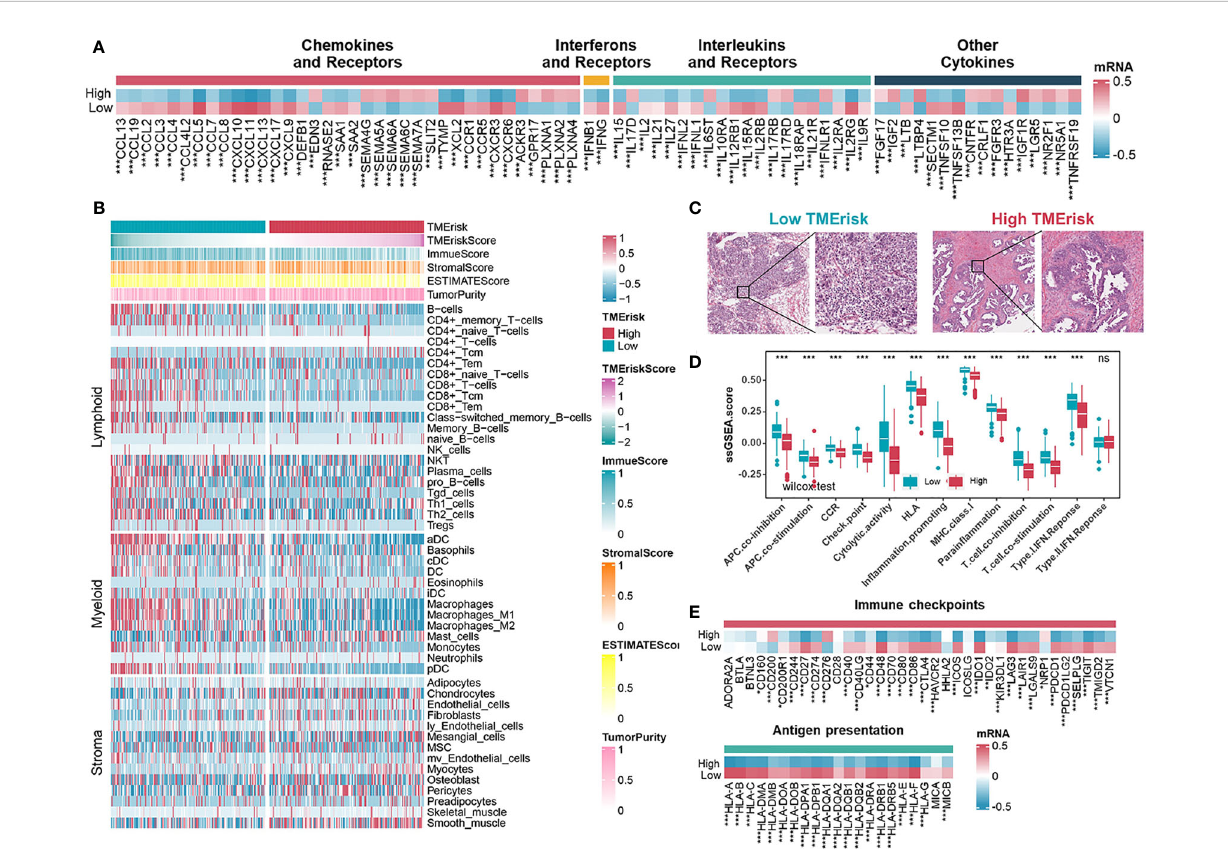
FIGURE 5 Immune landscape of different TMErisk groups in HGSOC. (A) Expression of chemokines, interferons, interleukins, and other cytokines in low- and high-TMErisk groups in TCGA-OV cohort. (B) Heatmap showing the in fi ltration of immune and stromal cells between low- and high-TMErisk groups in TCGA-OV cohort. (C) CDSA images of representative HE-stained samples of HGSOC from TCGA in low- and high-TMErisk groups. (D, E) Differences in immune-related functions (D) , immune checkpoints and HLA gene expression (E) between low- and high-TMErisk groups. ns P >